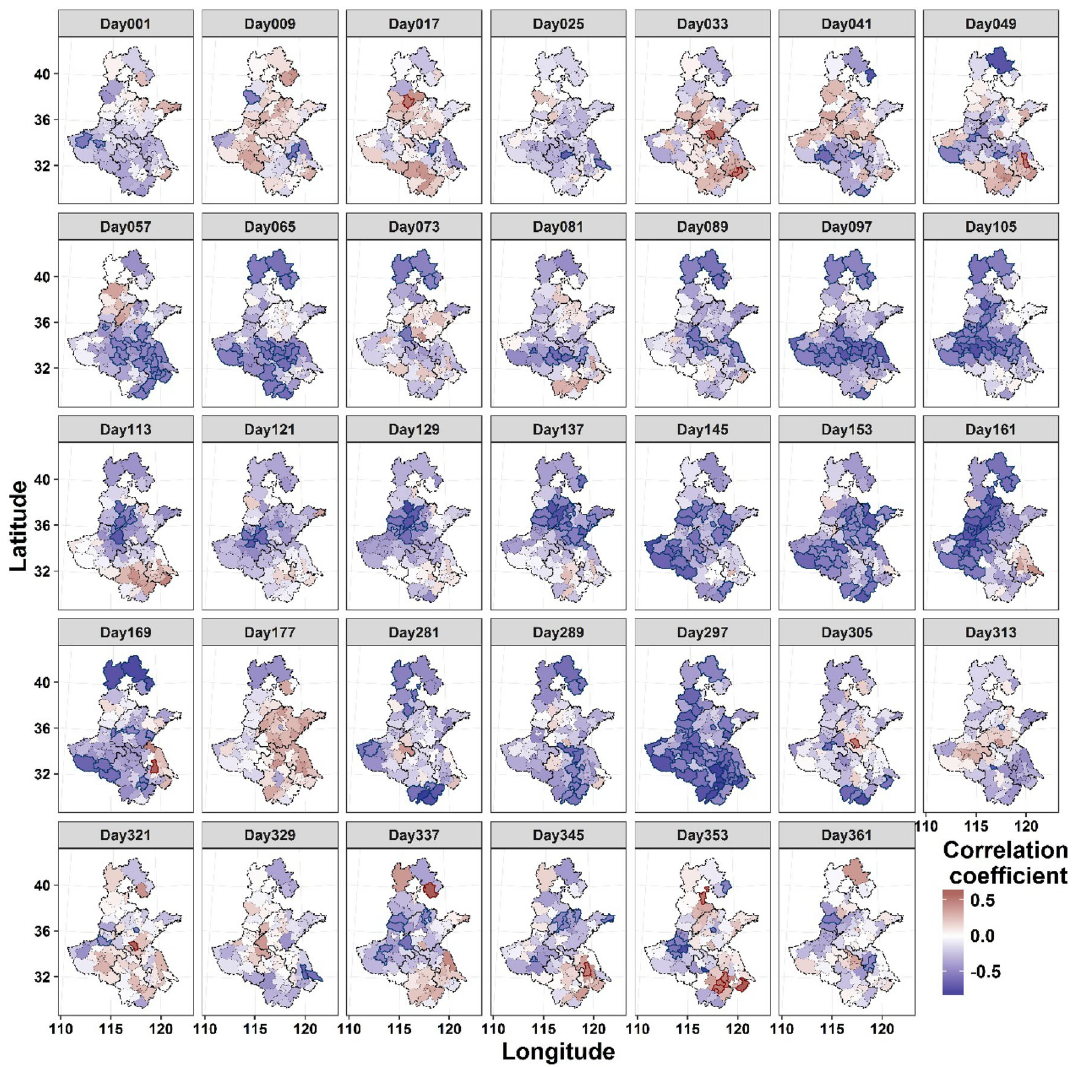
Fig. 7 Spatial pattern of correlations between mild drought-affected crop area and winter wheat yield in Anhui, Hebei, Henan, Jiangsu, and Shandong Provinces, China,